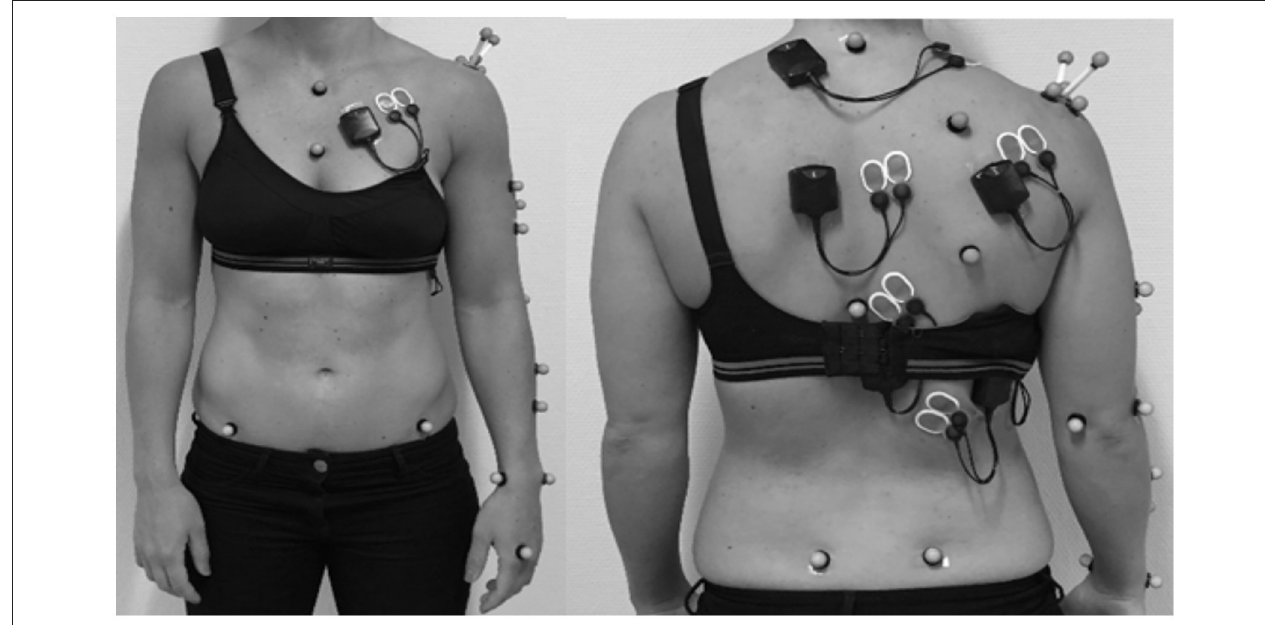
FIGURE 3 | Position of markers for measuring shoulder kinematics and electrodes for measuring shoulder muscle activity.